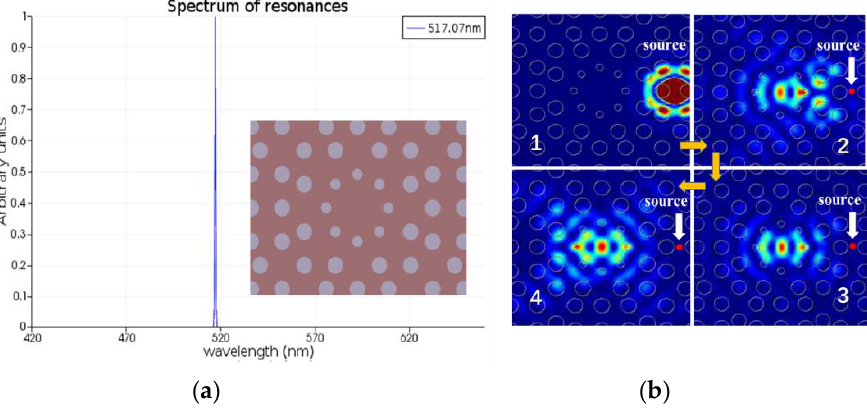
Figure 4. ( a ) Resonant peak output at 517 nm from an octagonal quasicrystal defect microcavity and the schematic geometry (the inset); ( b ) the evolution of intensity distribution over time with a point light source in the vicinity of a defect.